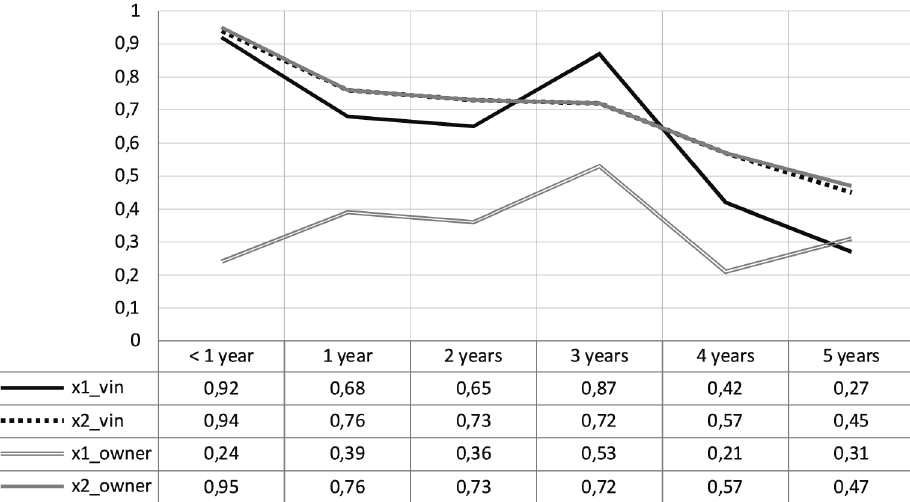
Figure 8. Summary of the SOSE